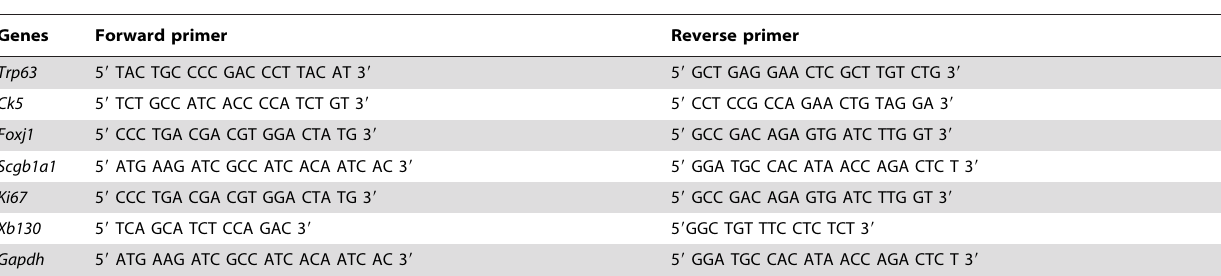
Table 1. Primers of the selected genes for quantitative RT-PCR.